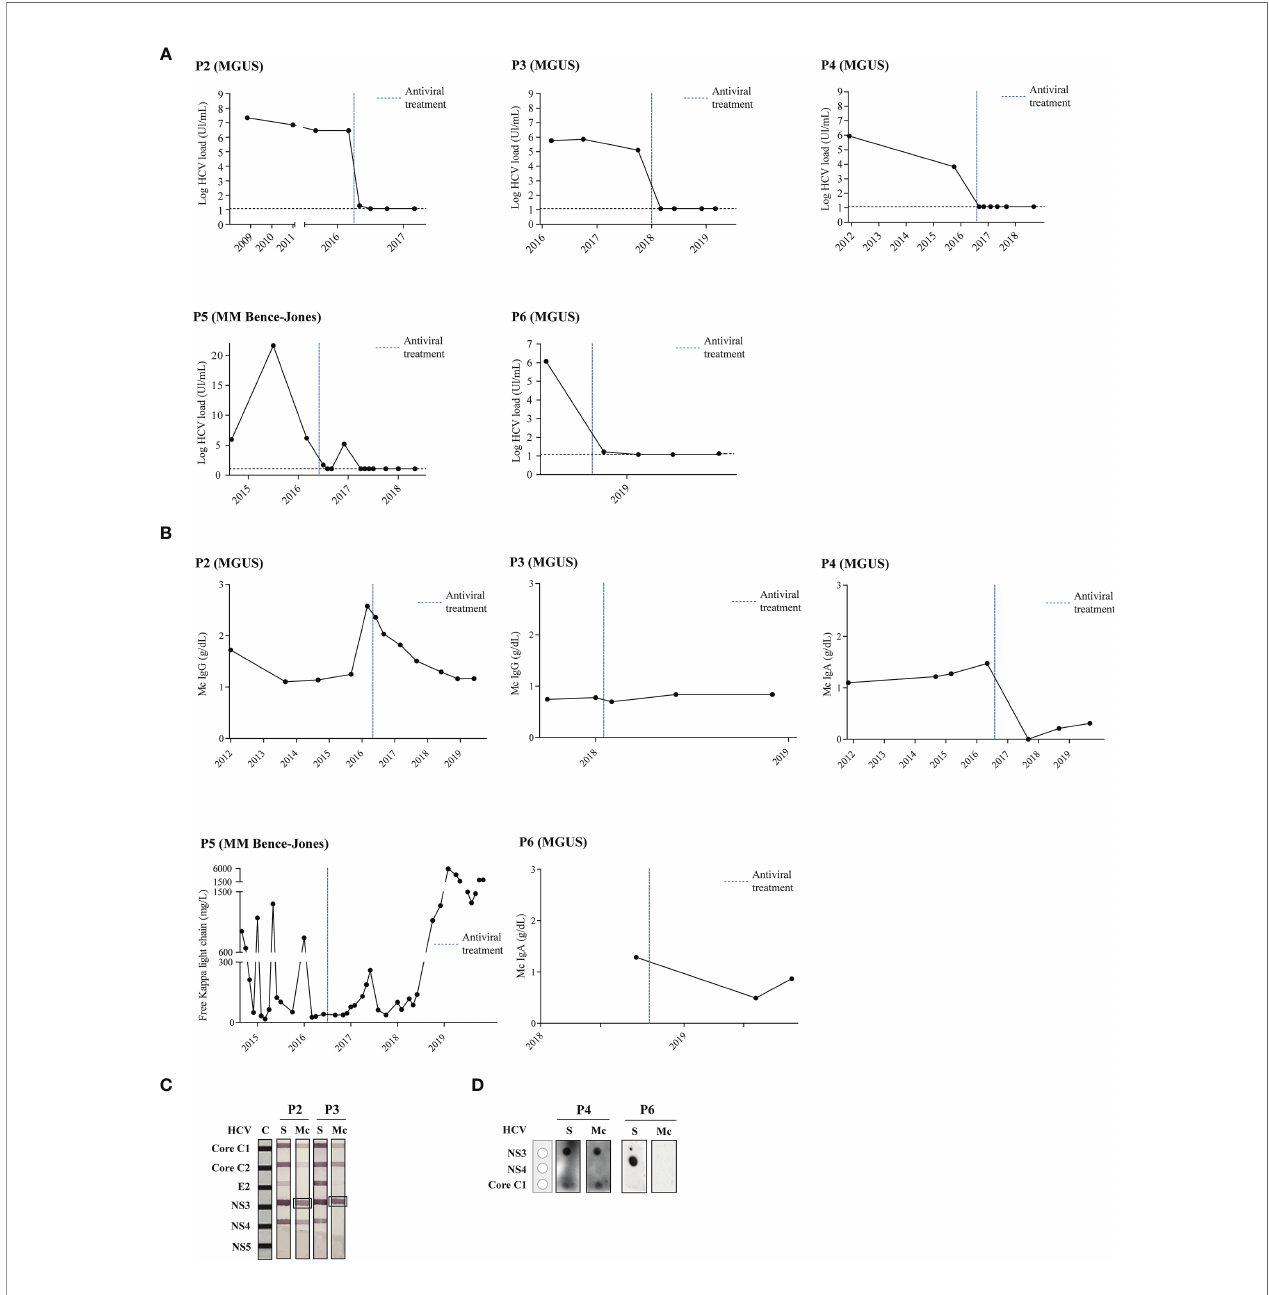
FIGURE 2 | Disease evolution and evaluation of HCV-speci fi city of the monoclonal Ig from patients who were treated with antiviral drugs. Panel (A) shows the HCV load quanti fi ed by reverse-transcriptase quantitative polymerase chain reaction in patients ’ serum. The black horizontal dotted line represents the threshold of virus detection. Panel (B) shows the quantity of monoclonal Ig as determined by serum protein electrophoresis. (A, B) The blue vertical dotted line indicates the time of antiviral treatment. Panel (C) shows the INNO-LIA ™ HCV test to detect reactivity of patients ’ serum IgGs and of the puri fi ed monoclonal IgG against different HCV proteins. Panel (D) shows the dot-blot assay to detect reactivity of patients ’ serum IgAs and of the puri fi ed monoclonal IgA against different HCV proteins (IgAs cannot be studied using the INNO-LIA ™ HCV test). The monoclonal IgA of patient P4 strongly recognized the HCV NS3 protein, whereas the monoclonal IgA of patient P6 did not recognize any HCV protein of the assay. C, positive controls; S, serum; Mc, monoclonal